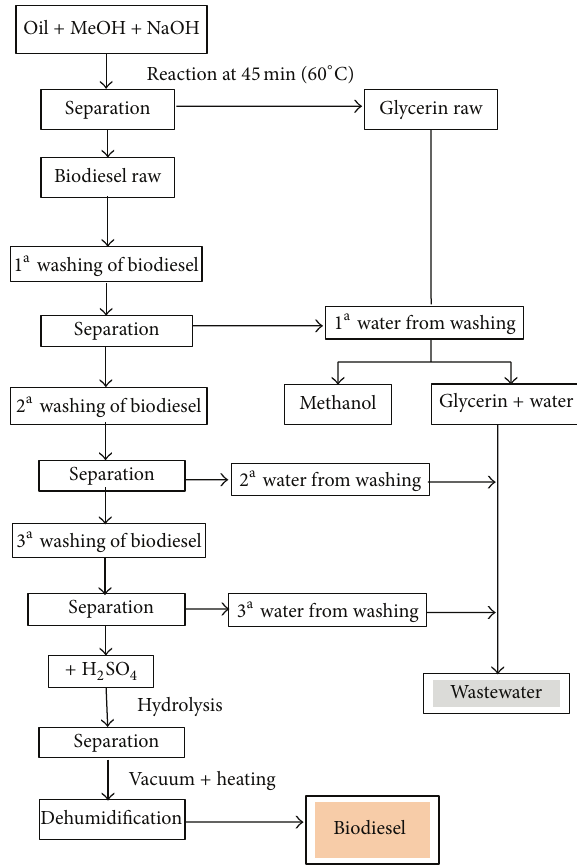
Figure 1: Process for producing biodiesel and the water from